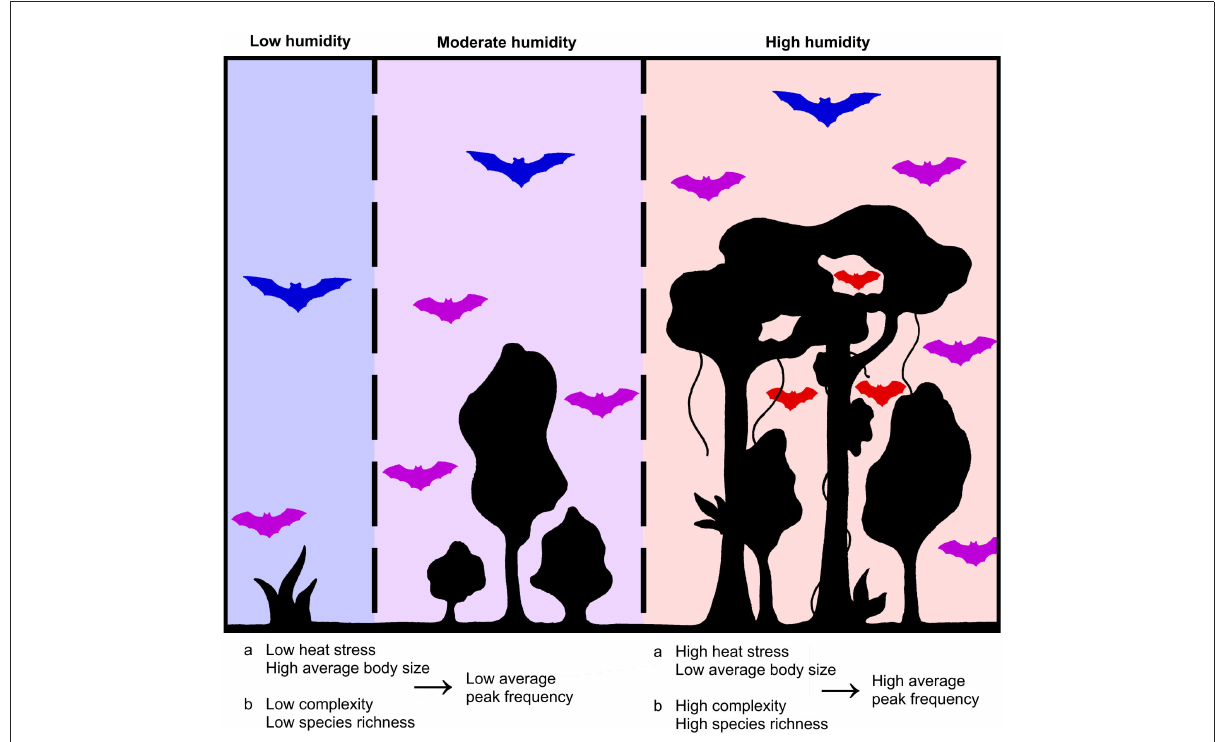
FIGURE2 Mechanisms leading to a lower average peak frequency in bat communities occurring in low-humidity area, and vice versa. According to the body mass constraint (a) and diversity (b) hypotheses: blue bats represent taxa with open space aerial hawking traits (low peak frequency), purple bats represent taxa with edge space aerial hawking traits, and red bats represent taxa with clutter foraging traits (high peak